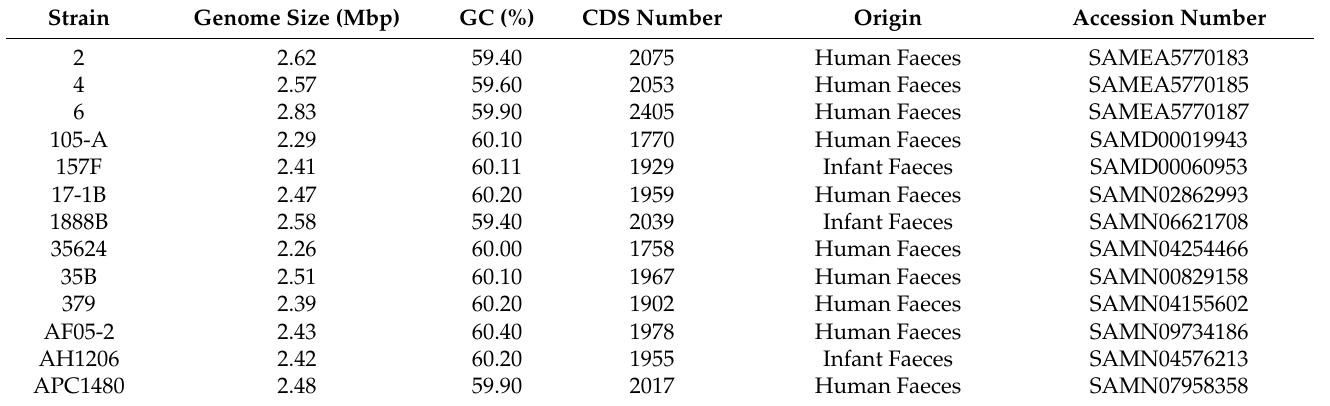
Table 1. The information of 80 B. longum